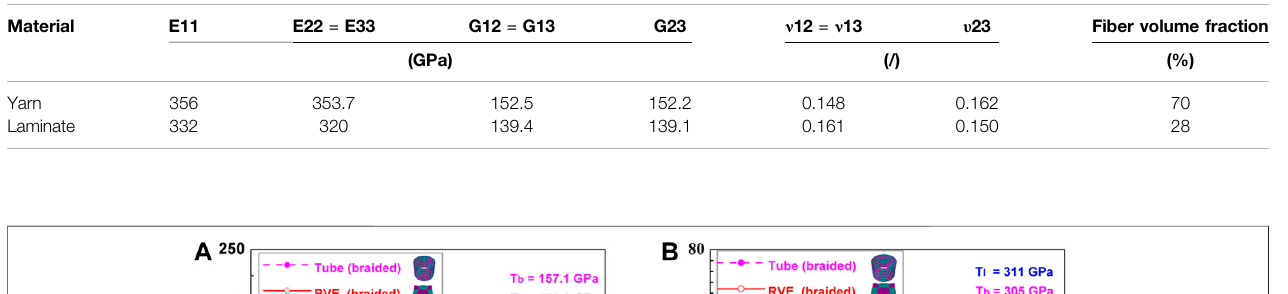
Frontiers in Materials |